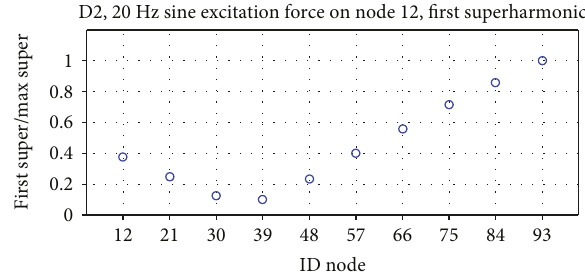
Figure 35: D2, 20Hz excitation in node 12, normalized 1st superharmonic.